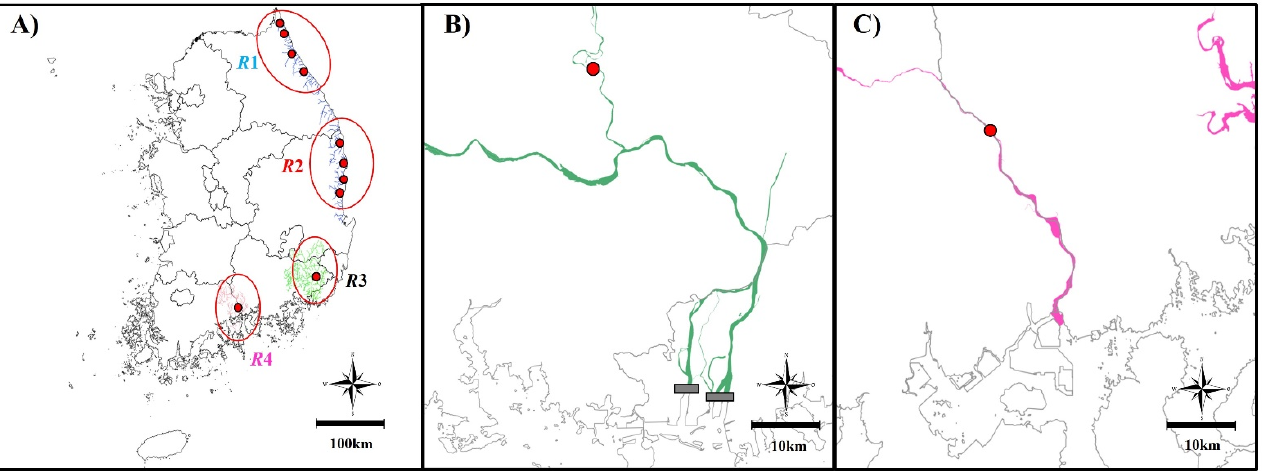
Figure 1. Distribution of study sites across South Korea. ( A ) In R 1 area, St. 1, St. 2, St. 3, and St. 4 exist from the uppermost part towards the lower regions. R 2 comprises St. 5 to St. 8 (St. 5 at the top), R 3 comprises St. 9, and R 4 comprises St. 10 (St. 1—the Myeong-pa stream, St. 2—the Buk stream, St. 3—the Namdae stream, St. 4—the Yeongok stream St. 5—the Song stream, St. 6—the Wang-pi stream, St. 7—the Pyeonghae-Namdae stream St. 8—the Osip stream, St. 9—the Milyang River, and St. 10—the Seomjin River). ( B ) Expansion of the R 3 region; Grey-rectangles are estuarine barrages existing in the mouth of the Nakdong River. ( C ) Expansion of the R 4 region.